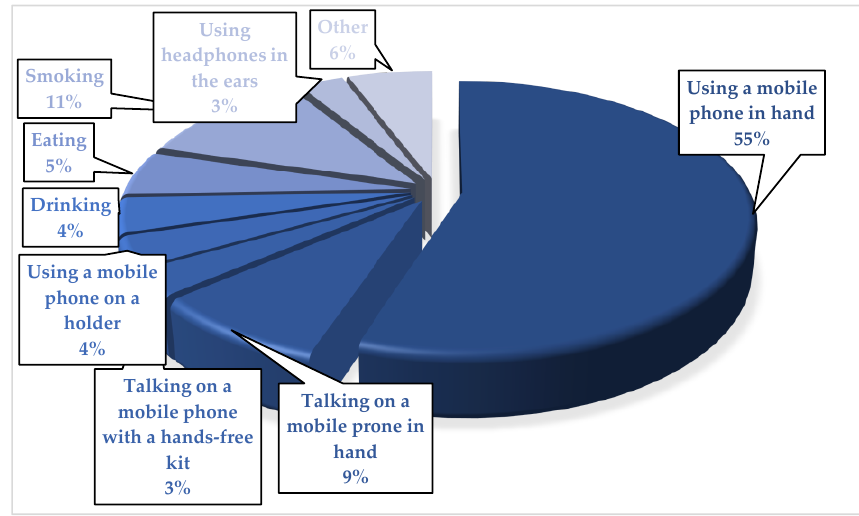
Figure 5. The results of the research on the expected behavior of vehicle drivers in the period after stopping due to the commencement of transmitting a red signal.